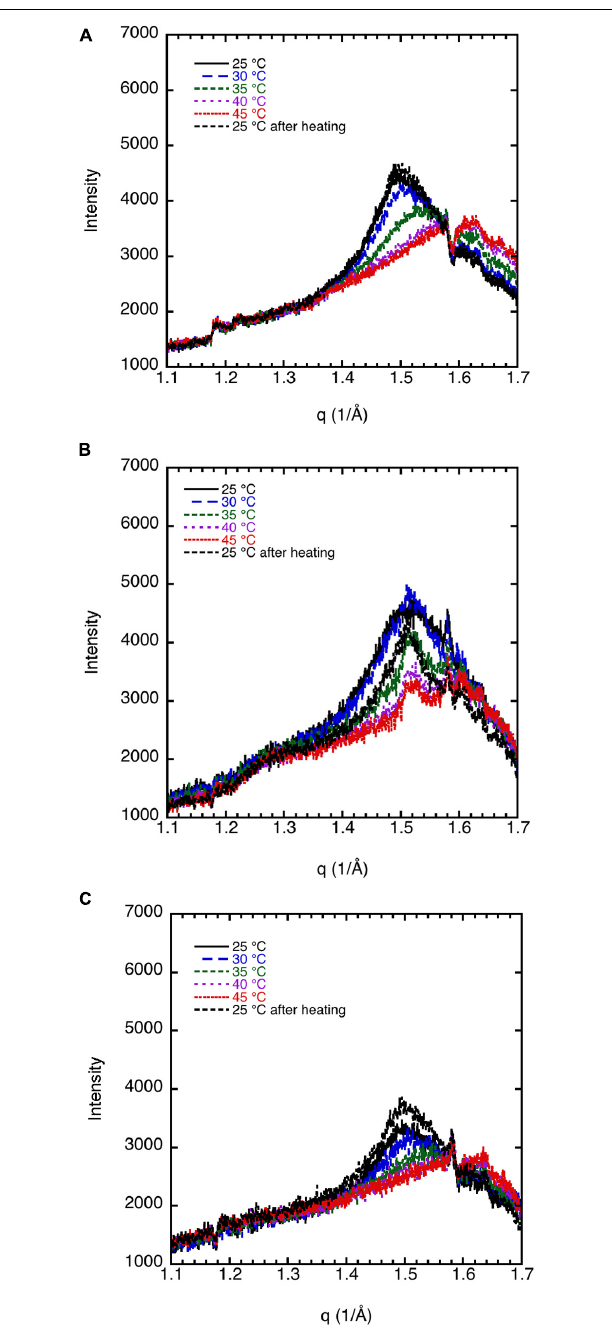
FIGURE 5 | WAXD data show the effect of salt composition on the ordering of porcine brain sphingomyelin, 65.1% sphingomyelin, and 4.9% cholesterol (7% of lipid) recorded at different temperatures. (A) In 0.9 wt% (154 mM) NaCl and 1 mM CaCl 2 , the peak position corresponds to spacing of 4.20 Å at 25 ◦ C, 4.17 Å at 30 ◦ C, rounded peak at 35 ◦ C, while no peak at higher temperatures. (B) In 0.9 wt% (154 mM) NaCl, the peak position corresponds to a spacing of 4.15 Å at 25–35 ◦ C, and no clear peaks at higher temperature. (C) In 0.8 wt% (137 mM) NaCl and in 0.1 wt% (24 mM) LiCl, the peak position corresponds to a spacing of 4.20 Å at 25 ◦ C, a less defined peak at 4.15 Å at 30 ◦ C, and no peaks at higher temperatures. Note that the intensity is scaled so to obtain the same background for all